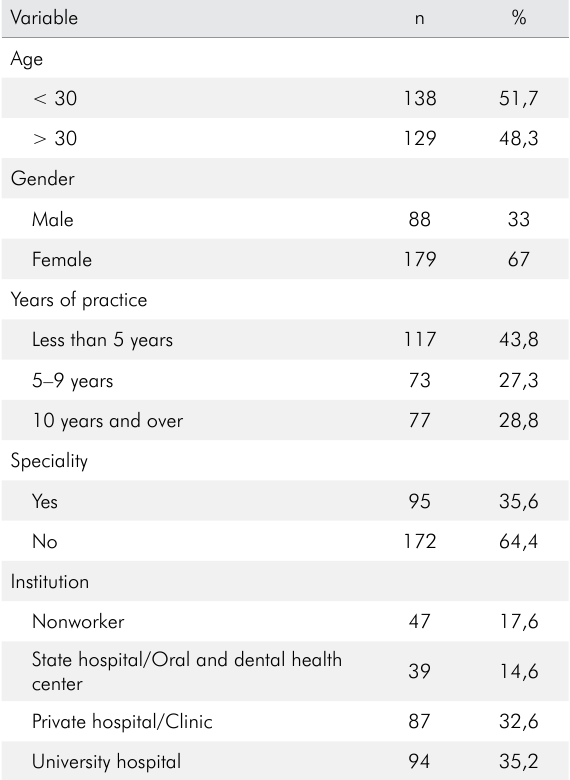
Table 2. Distribution of the participants’ characteristics.